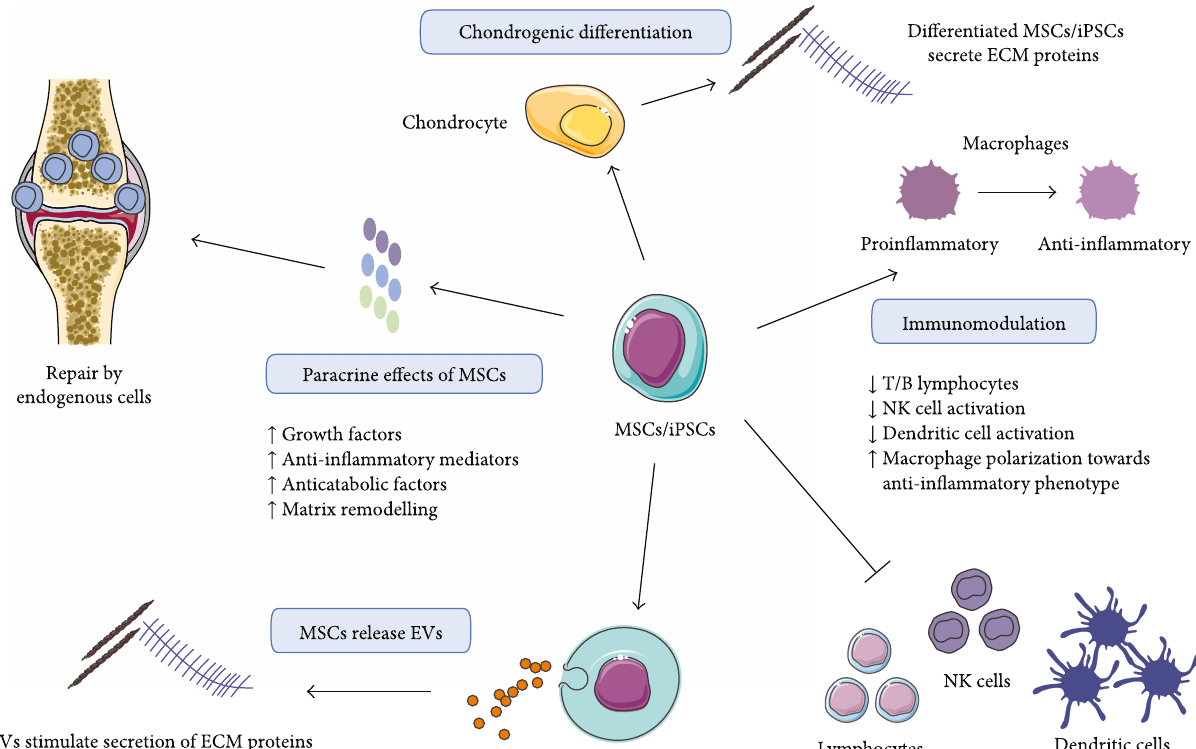
Figure 1: Mechanisms of action of stem cell-based therapies in cartilage regeneration. First, stem cells could be applied as cell replacement therapy because of their chondrogenic di ff erentiation potential. Di ff erentiated mesenchymal stem cells (MSCs) and induced pluripotent stem cells (iPSCs) secrete proteoglycans and collagen II. Secondly, it is suggested that the tissue is regenerated by endogenous cells under the in fl uence of paracrine factors secreted by stem cells. Extracellular vesicles (EVs) contribute to stem cell-mediated cartilage regeneration by promoting the formation of new cartilage and the deposition of collagen II and GAGs. Finally, immunomodulatory e ff ects are also observed. This image was created using Servier Medical